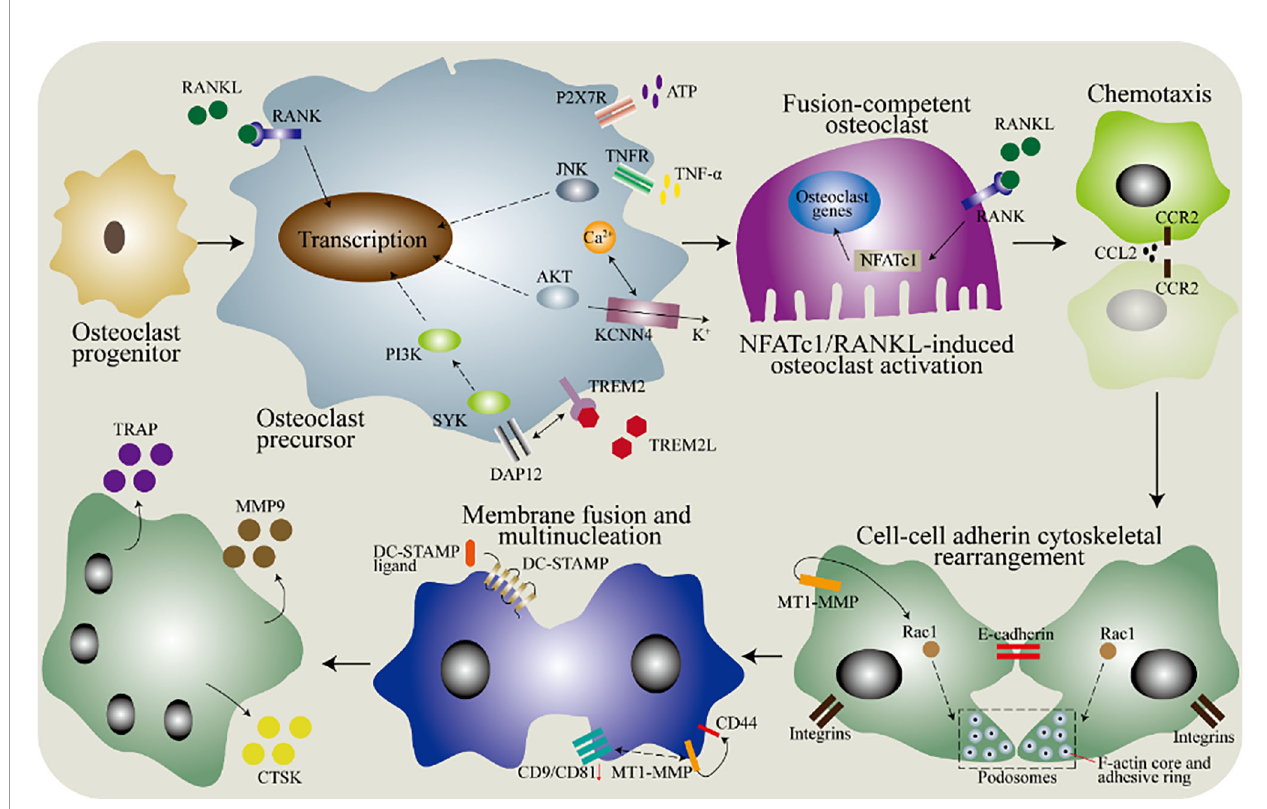
FIGURE 3 | The molecular mechanism of the fusion of monocytes/macrophages into osteoclasts. In the bone marrow, osteoclasts progenitors differentiate into precursor cells after being stimulated by macrophages colony stimulating factor (M-CSF), and then various factors are needed to induce the fusion ability. In the osteoclasts precursor, DNAX activating protein 12 (DAP12) binds to triggering receptor expressed on myeloid cells 2 (TREM-2) to cause a signal via spleen tyrosine kinase (SYK). The purinergic receptor P2X7 (P2X7R) has a regulatory role and acts through the ATP-adenosine axis. Tumor necrosis factor (TNF) binds to the TNF receptor (TNFR) to activate the downstream c-Jun N-terminal kinase (JNK). Besides, the potassium calcium-activated channel subfamily N member 4 (KCNN4) contributes to continuous Ca 2+ signaling and downstream activation of protein kinase B (AKT). Then, the chemotaxis of macrophages brings them close to each other, which is mediated by the binding of C-C motif chemokine ligand 2 (CCL2) to its receptor. The adhesion between cells is partially mediated by E-cadherin and integrin, and the subsequent cytoskeletal rearrangement is regulated by RAC1, which is regulated by membrane type 1 matrix metalloproteinase (MT1-MMP). Finally, the dendrocyte expressed seven transmembrane protein (DCSTAMP) mediates membrane fusion, and then forms osteoclasts through cell-cell fusion. Down- regulation of CD9 and CD81 is necessary for membrane fusion. The interaction between transmembrane protein and MT1-MMP has been determined, but further research is needed. In addition, CD44 can also mediate membrane fusion by interacting with MT1-MMP. Osteoclasts produce tartrate-resistant acid phosphatase (TRAP), matrix metallopeptidase 9 (MMP9) and cathepsin K